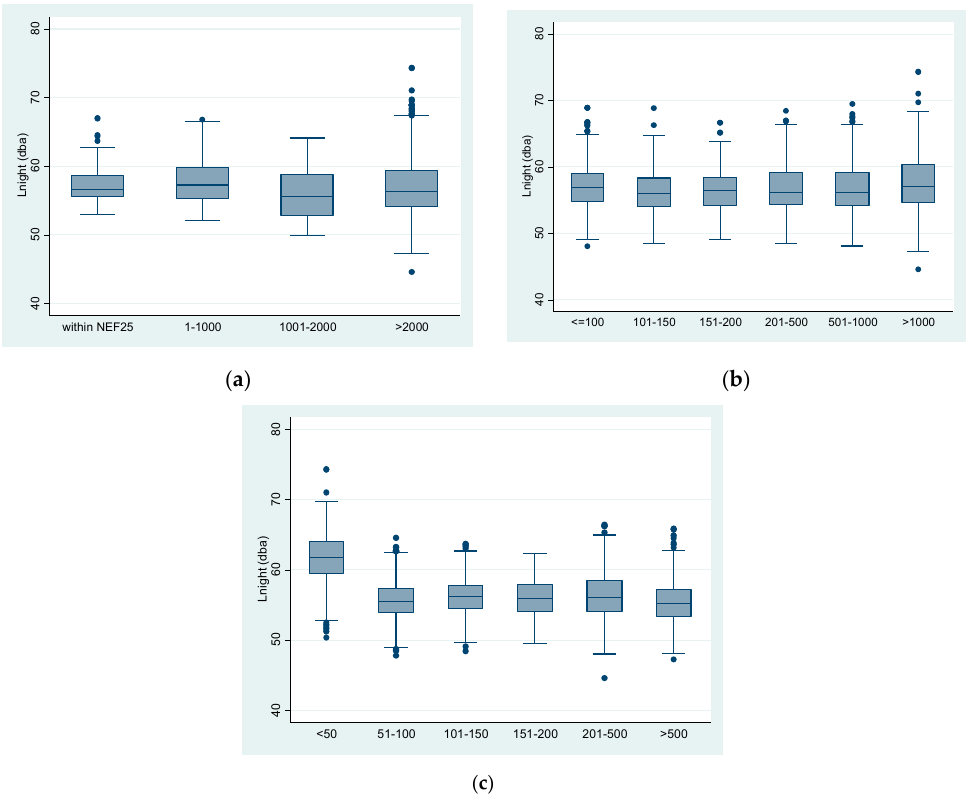
Figure A1. Relation between predicted L Night and distance to: ( a ) NEF25; ( b ) railway; ( c ) major road. Table A1. Log-binomial regression models for sleep disturbance due to airplanes in relation to the distance to the NEF25 contour of the Montreal International Airport. All variables are in a same model.